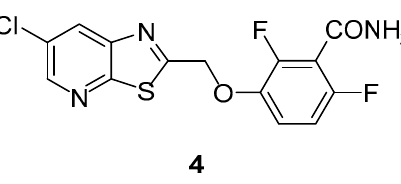
Table 1. MM-GBSA binding energies of compound 3 and PC190723 4 on FtsZ (PDB ID: 4DXD).